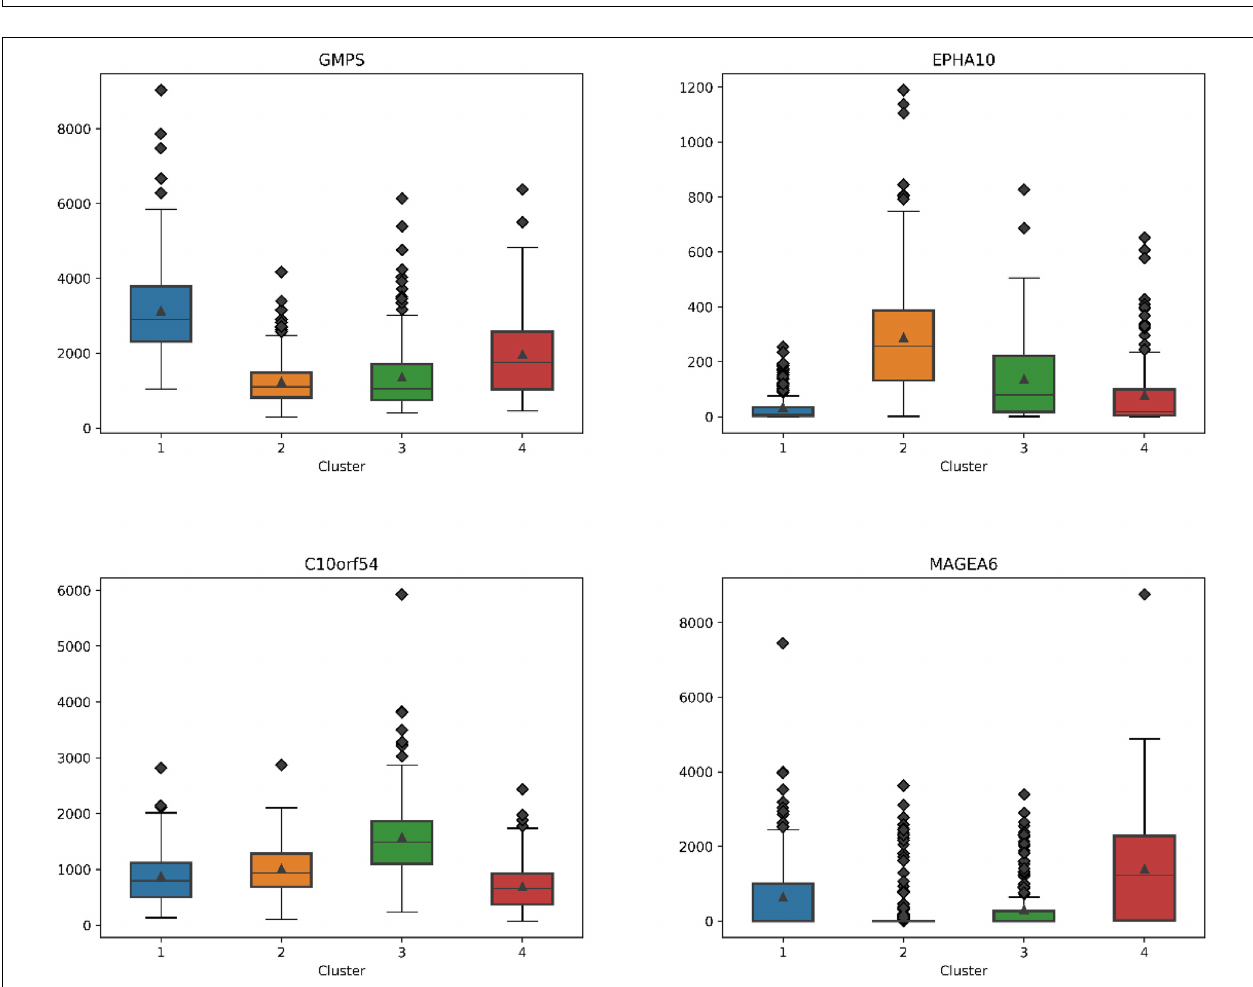
FIGURE 4 | The boxplots for essential genes supporting each subtype on LUNG.